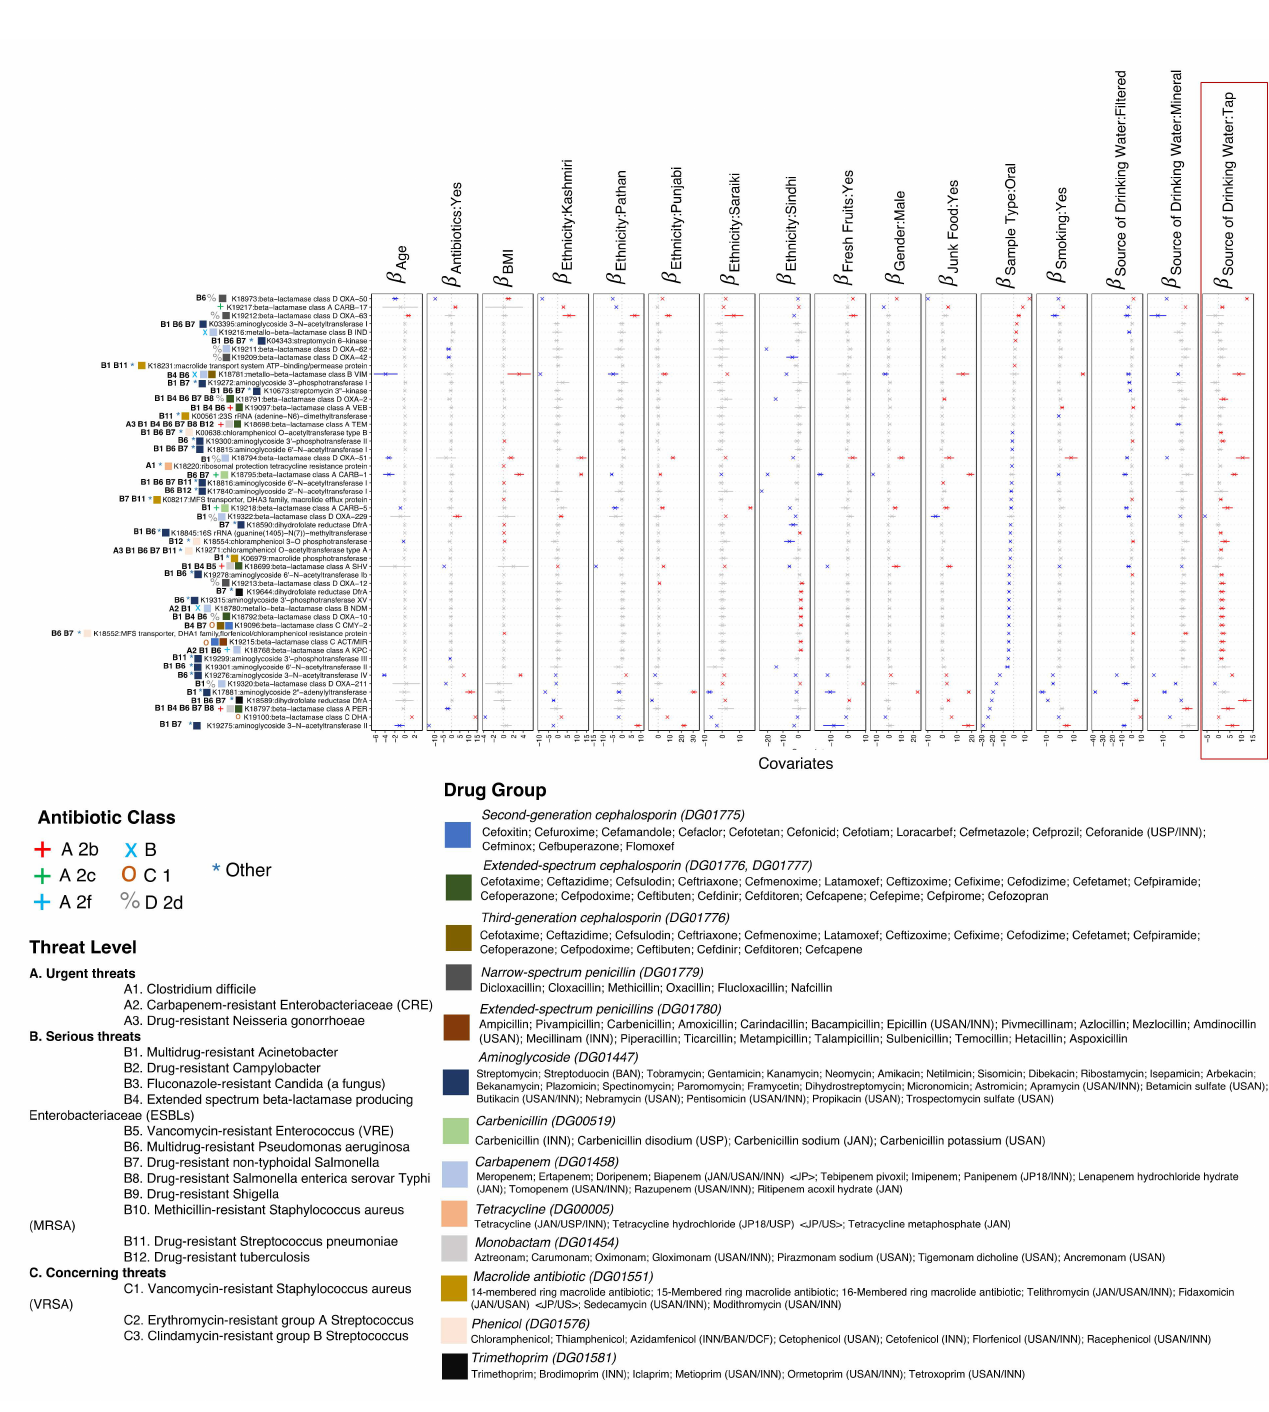
Figure 3. β − coefficients returned from GLLVM procedure for covariates considered in this study by considering the 52 predictive antimicrobial resistance genes (piARGs) detected in this study using PICRUSt2 procedure. Those coefficients which are positively associated with the abundance of a particular piARGs are represented in red colour whilst those that are negatively associated are represented with blue colour, respectively. Where the 95% confidence interval of the β − coefficients cross the 0 boundary, the coefficients are insignificant and are represented by grey colour. Additional annotations comprise of threat levels, classes, and drug groups these piARGs are categorized